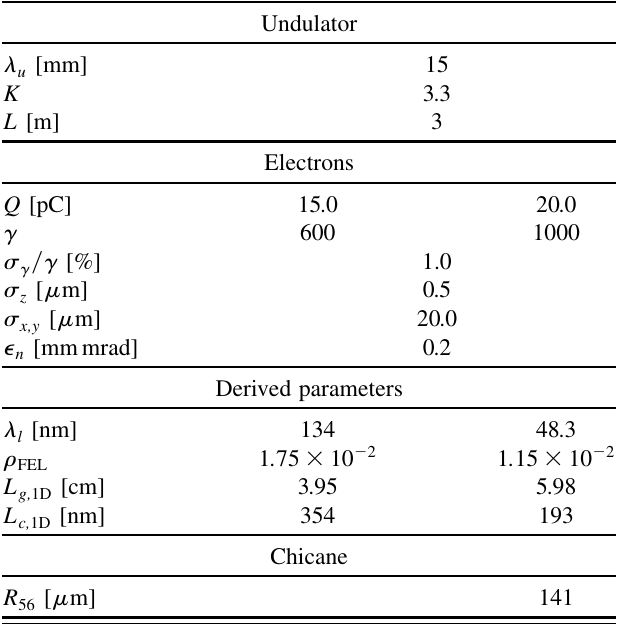
TABLE I. Setup and electron parameters for long and short wavelength case used in 1D and 3D